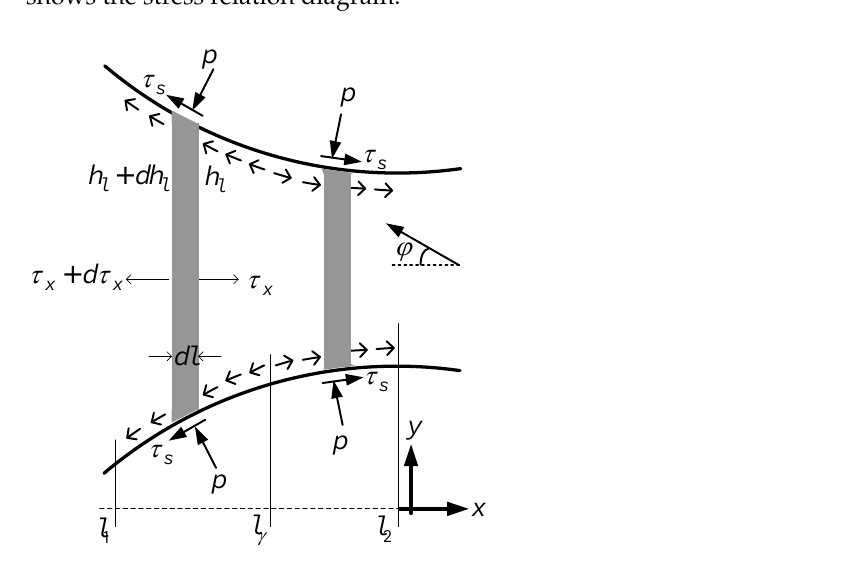
Figure 9. Stress relation diagram at any position in the deformation zone.